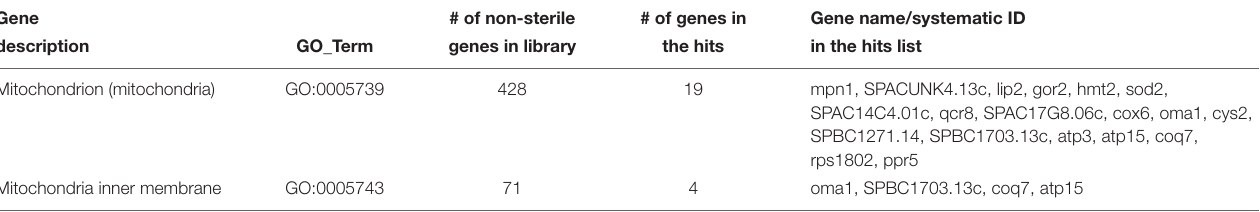
TABLE 2 | Mitochondria-related genes, as determined by GO terms, which are genetically interacting with ate1 . Gene # of non-sterile # of genes in